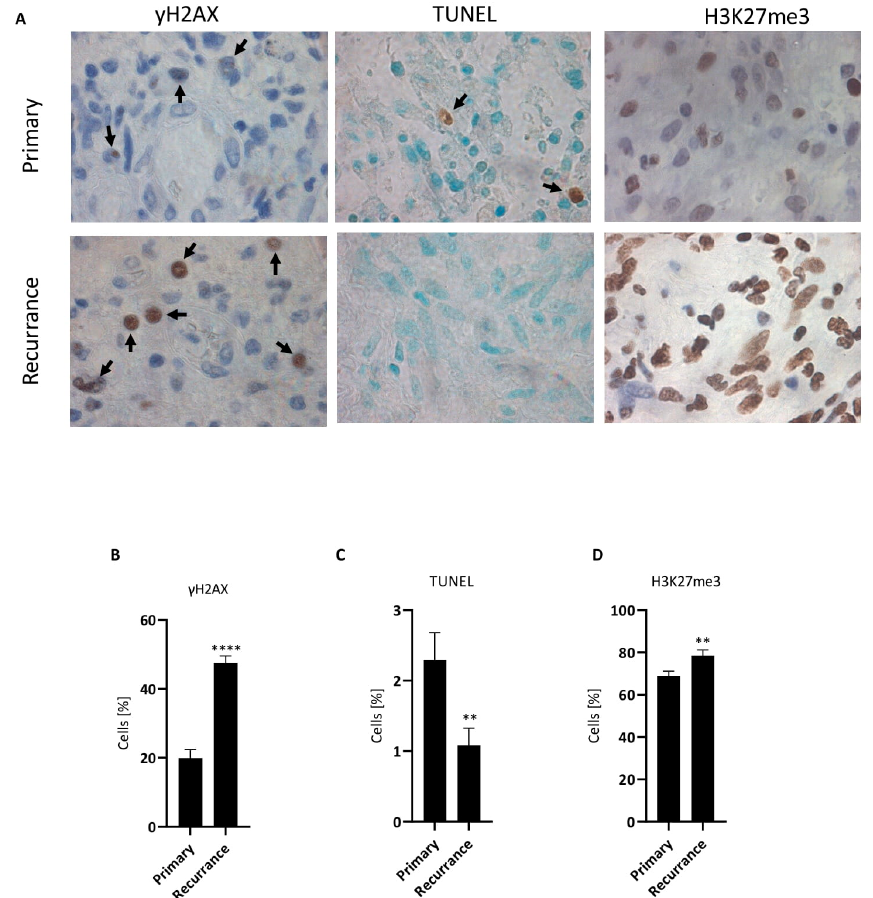
Figure 8. Immunostaining with γ H2AX, TUNEL, and H3K27me3 in tumor sections of primary GBM and recurrences. ( A ) Representative images of γ H2AX and TUNEL staining. ( B ) Quantification of γ H2AX staining (% positive cells), ( C ) TUNEL-positive and ( D ) H3K27me3-positive cells. In all cases, the difference between primary tumor and recurrence was highly significant (** p <0.01, **** p <0.0001).